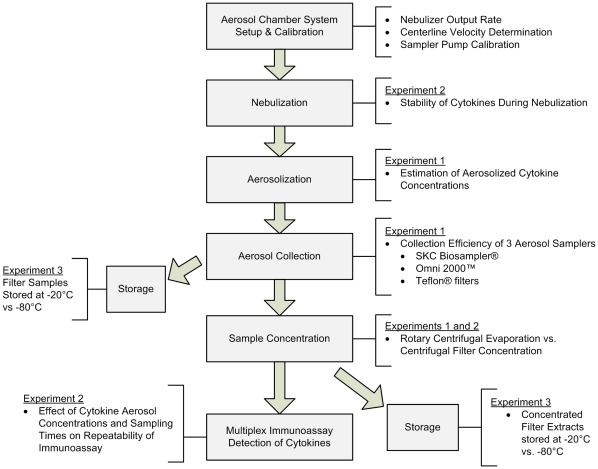
Summary of experiments and methods.